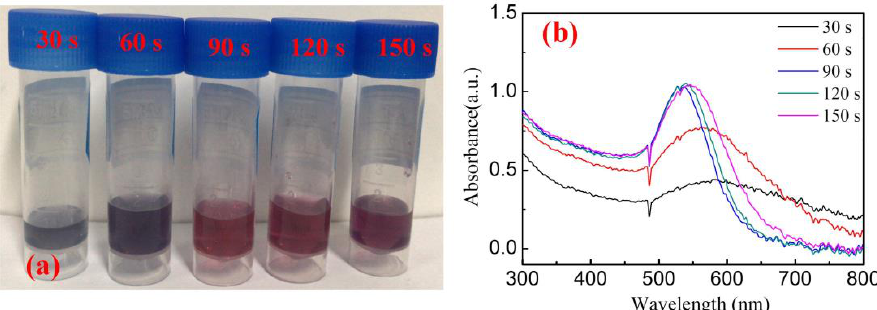
Figure 4. ( a ) Photos and ( b ) UV–Vis absorption spectra of AuNP for process times of 30, 60, 90, 120, and 150 s.